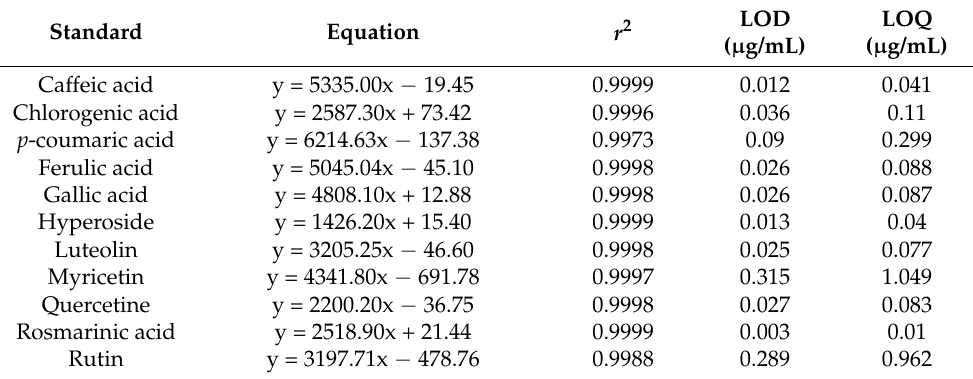
Table 1. Calibration curve parameters for flavonoids and phenolic acid